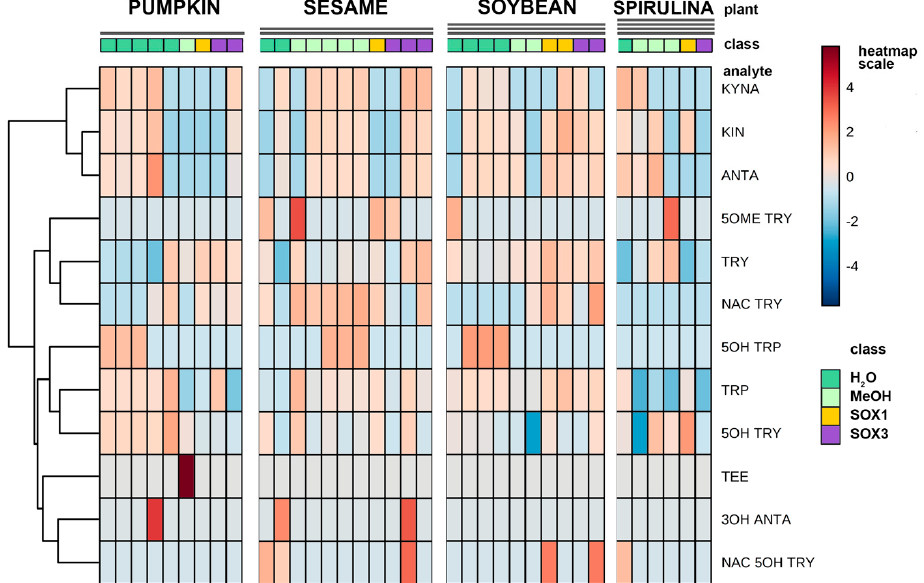
Figure 4. Hierarchical clustering heatmap representation of the concentration of the indolic compounds of four different plant matrices taking into consideration the different type of extractions (green: water extraction at room temperature; light green: methanol extraction at room temperature; yellow: extraction in a Soxhlet apparatus with methanol only, and violet: defatting with petroleum ether and dichloromethane and successive extraction with methanol in a Soxhlet apparatus). The concentrations were autoscaled and log-transformed for visualization. The color- scale differentiates values as high (red), mid (grey) and low (blue).